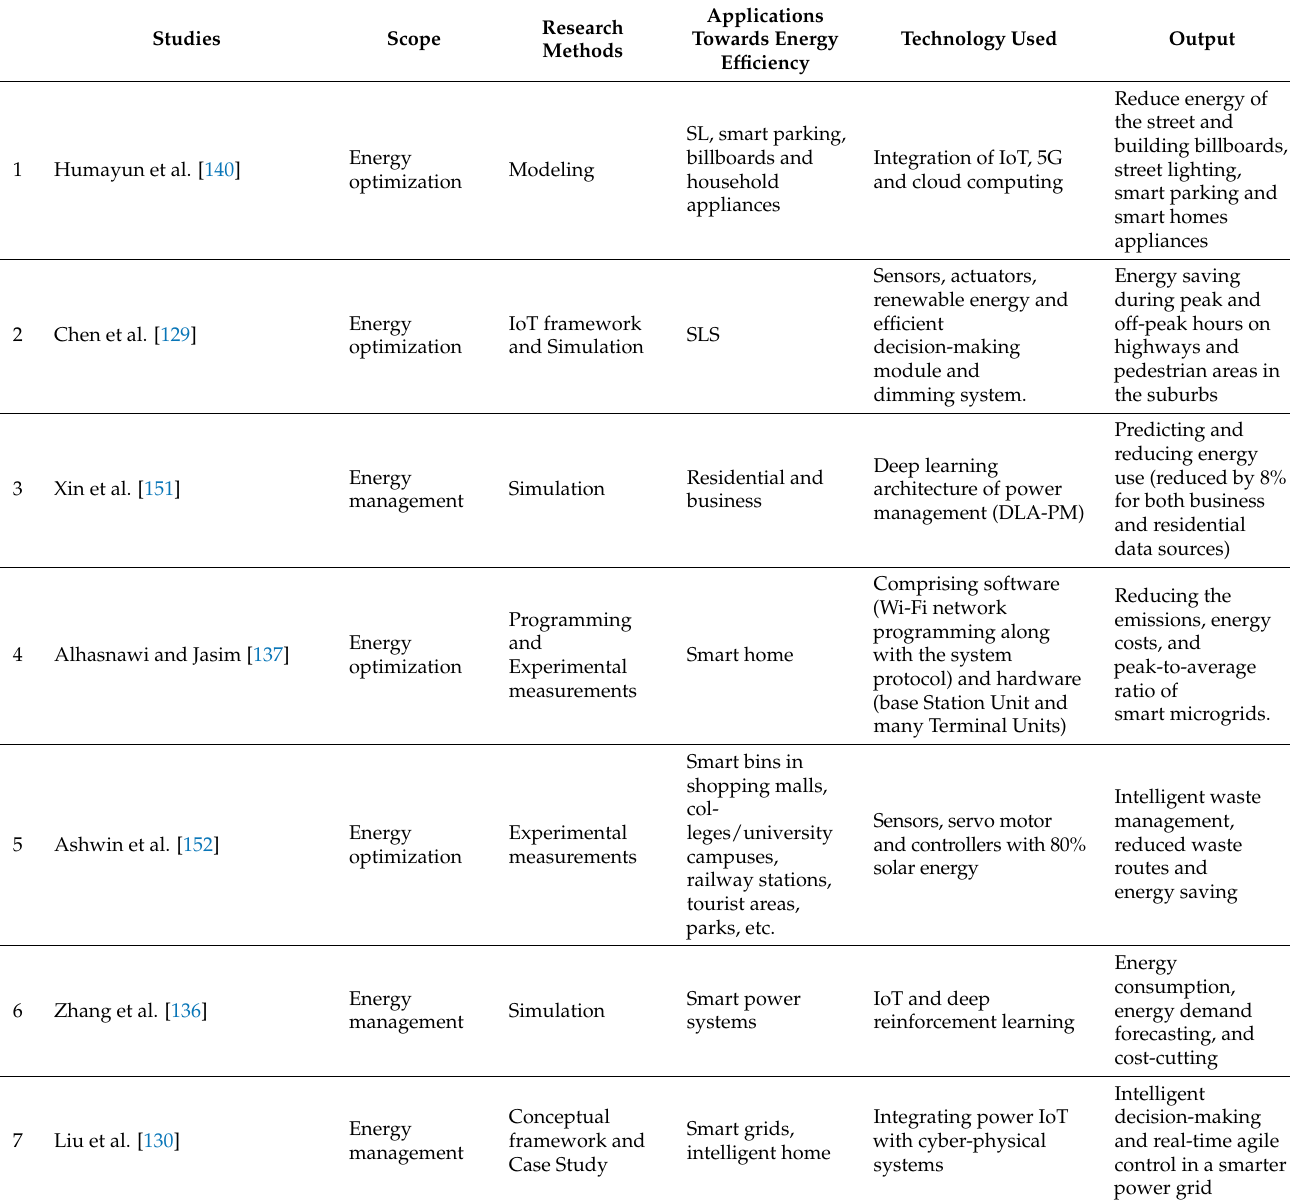
Table 4. Summary of recent studies on IoT towards energy efficiency in smart